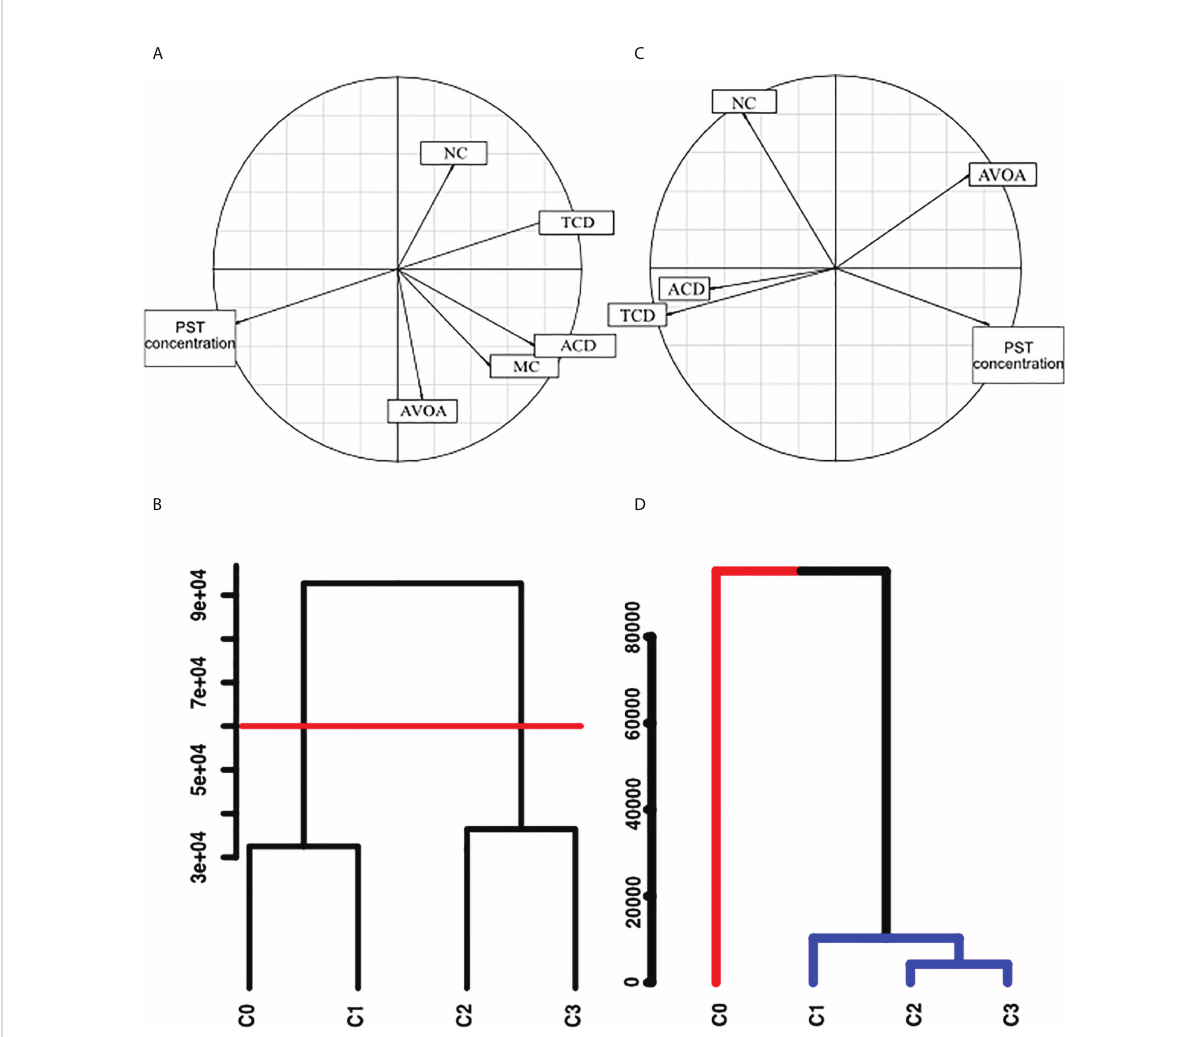
FIGURE 5 (A) Correlation circle of Principal Component Analysis for the behavioural indicators (NC, Number of closures. TCD, Total Closure Duration; ACD, Average Closure Duration; AVOA, Average VOA; MC, Microclosure) in the laboratory experiment during the period T1 (addition of A. catenella), in relation to PST concentration in mussel. (B) Cluster analysis of behavioural indicators in relation to PST concentration in mussels during laboratory experiment. C0:<20 m g STXeq 100g-1, C1: 20 to 50 m g STXeq 100g-1, C2: 50 to 80 m g STXeq 100g-1, C3: >80 m g STXeq 100g-1; The red line represents a separation between the concentration groups established from these two clusters. This line was traced at the higher distance between two knots of the cluster representing a group with the concentration C0 and C1 and a second group with the concentrations C2 and C3, (C) Correlation circle of Principal Component Analysis for the behavioural indicators in the natural seawater experiment and PST in mussels, (D) Cluster analysis for groupings of PST concentrations with behavioural indicators in natural seawater experiment by SIMPROF method, C0:<10 m g STXeq 100g-1, C1: 30 to 50 m g STXeq 100g-1, C2: 50 to 80 m g STXeq 100g-1, C3: >80 m g STXeq 100g-1. Red line: group 1, blue line, group